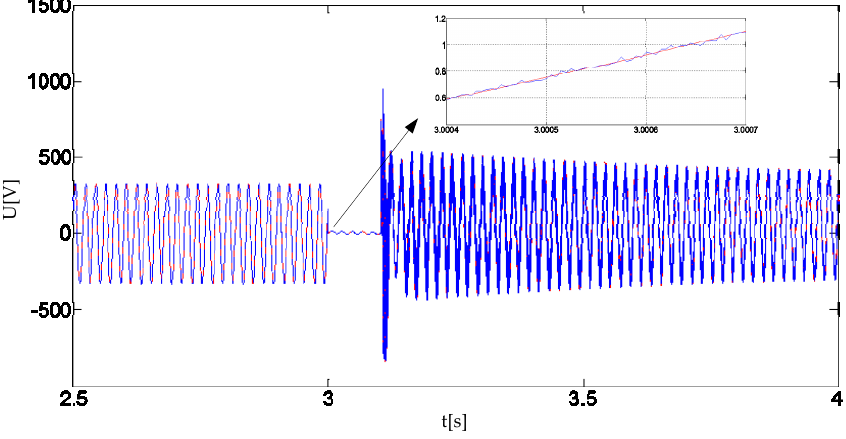
Figure 9. The three-phase output voltage waveform of node 37.